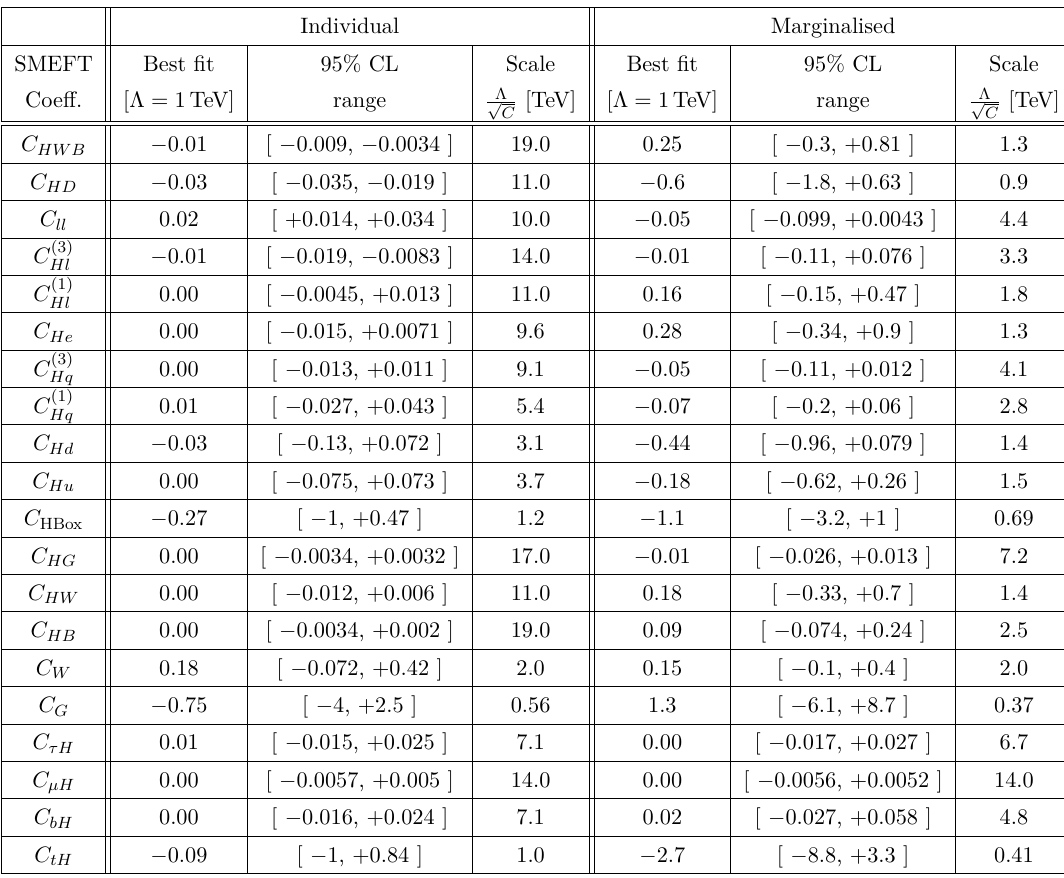
Table 1 . Table of the numerical results from the global fits to the electroweak, diboson and Higgs data in the CDF-friendly flavour-symmetric SU(3) 5 scenario that are visualised in figure 3, switching on only each individual operator (left columns) and including all operators and marginalising over the other operator coefficients (right